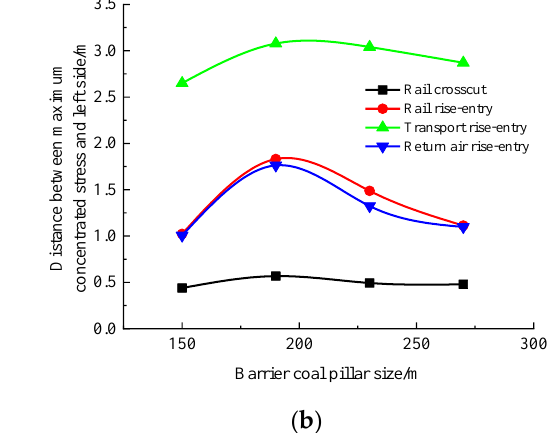
Figure 15. Maximum concentrated stress and its location monitoring results under different sizes of rise-entry barrier coal pillar conditions. ( a ) Maximum concentrated stress, ( b ) Position of maximum concentrated stress.